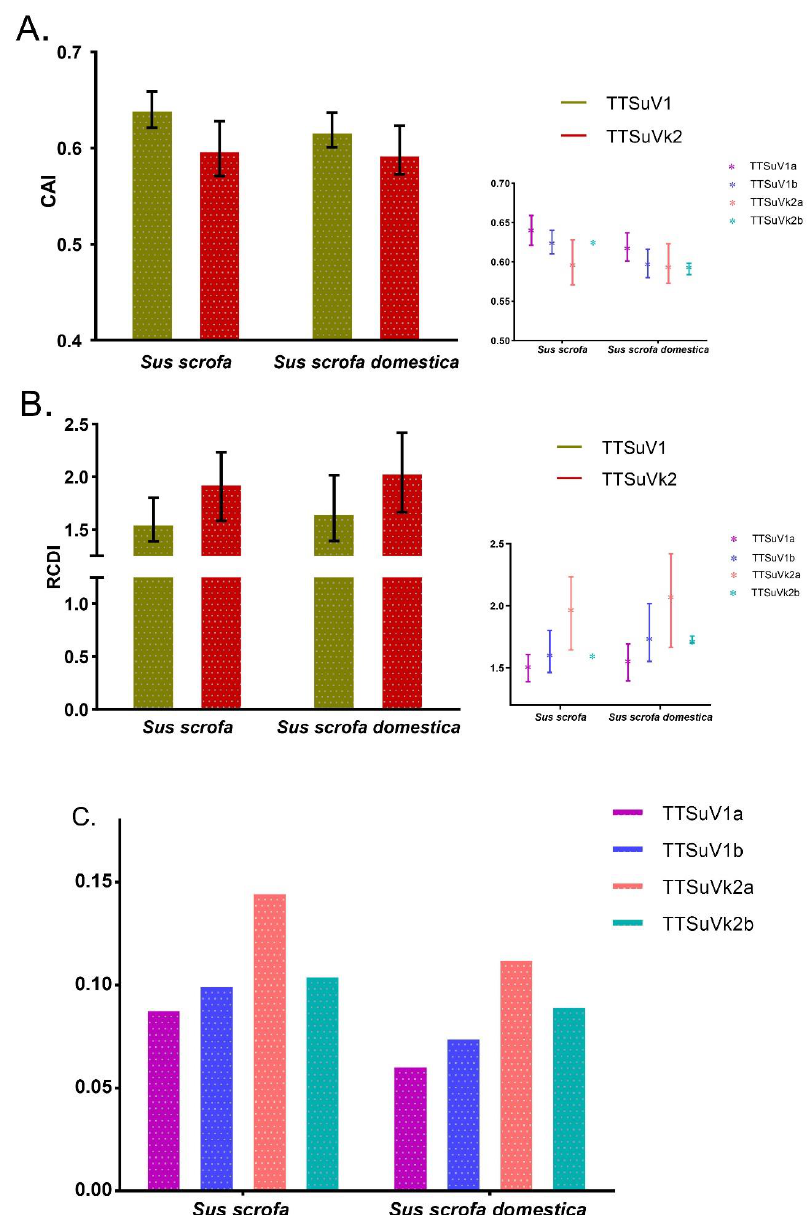
Figure 5. Codon adaptation index (CAI) ( A ), relative codon deoptimization index (RCDI) ( B ), and similarity index (SiD) ( C ) analysis of TTSuV. TTSuV1 is represented in green-brown and TTSuVk2 is represented in red, while TTSuV1a, TTSuV1b, TTSuVk2a, and TTSuVk2b are represented in purple, blue, pink and green,